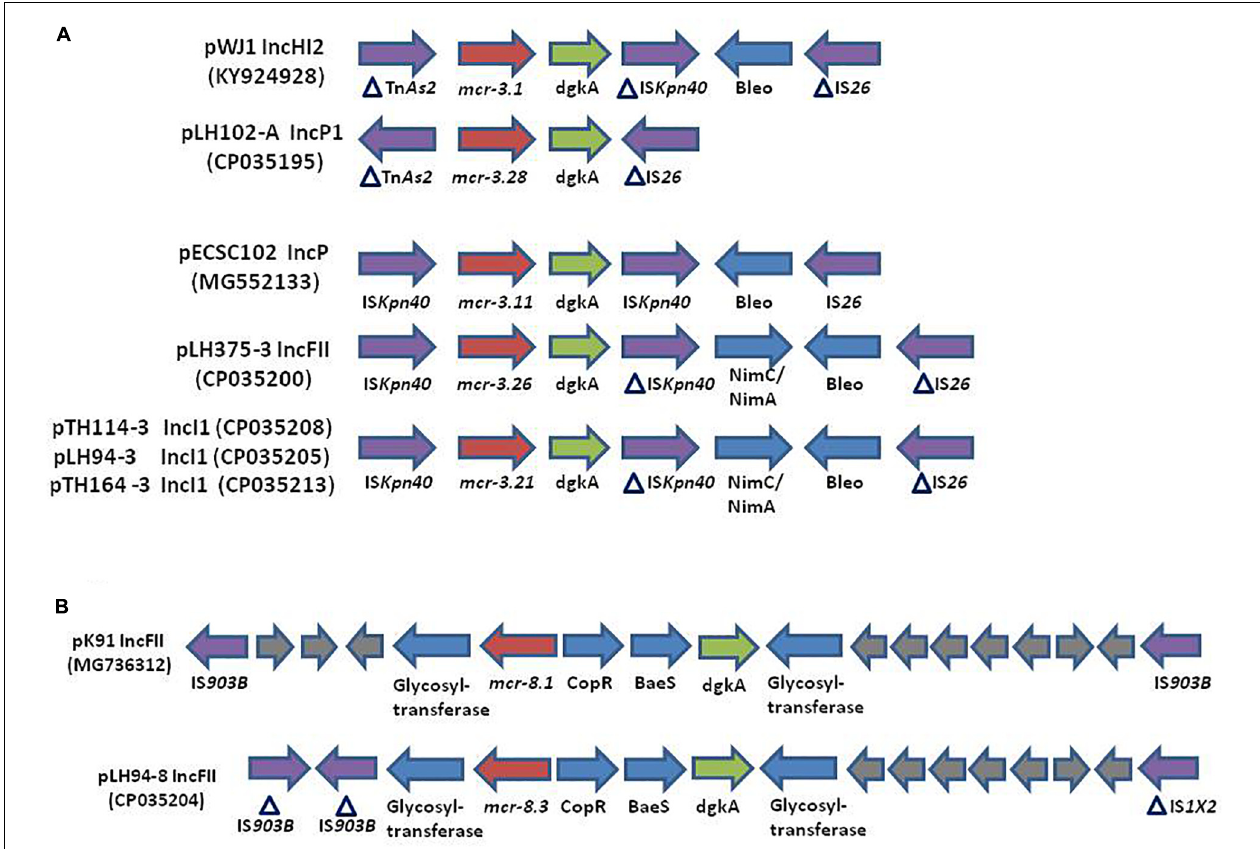
FIGURE 3 | (Not to scale) (A) Comparison of the genetic environment of the mcr-3 gene in plasmids: pWJ1 (KY924928), pLH102-A (CP035195), pECSC102 (MG552133), pLH375-3 (CP035200), pTH114-3 (CP035208), pLH94-3 (CP035205), and pTH164-3 (CP035213). (B) Comparison of the genetic environment of the mcr-8 gene in plasmid pK91 (MG736312) and in the plasmid of strain LH94 carrying mcr - 8.3 gene: pLH94-8 (CP035204). HP, hypothetical protein, IS, insertion sequence, Tn,